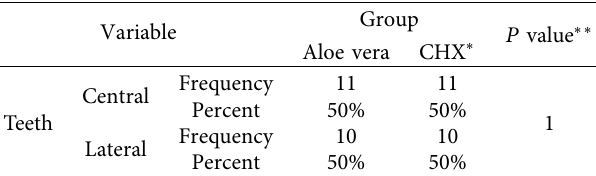
Figure 1: Frequency distribution of teeth in terms of two groups (aloe vera and CHX). Table 1: The comparison of the frequency distribution of teeth between the two groups (aloe vera and CHX)